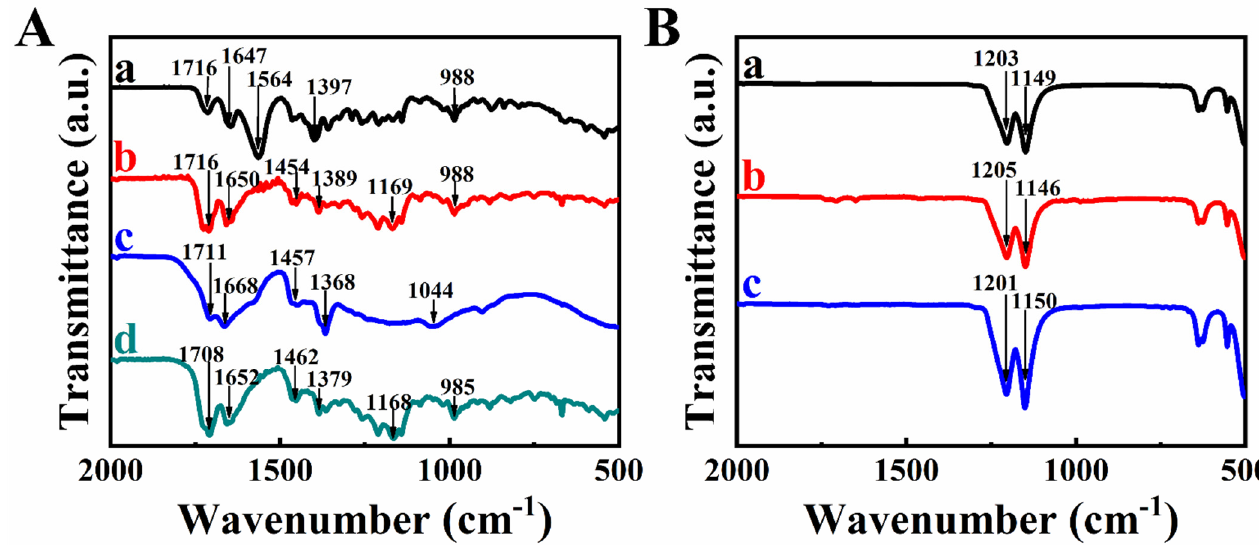
Figure 5. FTIR testing data for ( A ) (a) original CBXNa 2 , (b) film material, formed from 1gL ⁻ 1 CBXNa 2 in water at 15 V, (c) carbon dots, (d) deposit formed from 0.5 gL ⁻ 1 CBXNa 2 with 0.5 gL ⁻ 1 carbon dots in water at 15 V; ( B ) (a) PTFE (b,c) deposits, obtained from 1 gL ⁻ 1 CBXNa 2 with (b) 0.5 gL ⁻ 1 and (c) 1 gL ⁻ 1 PTFE in ethanol-water solvent at 50 V.